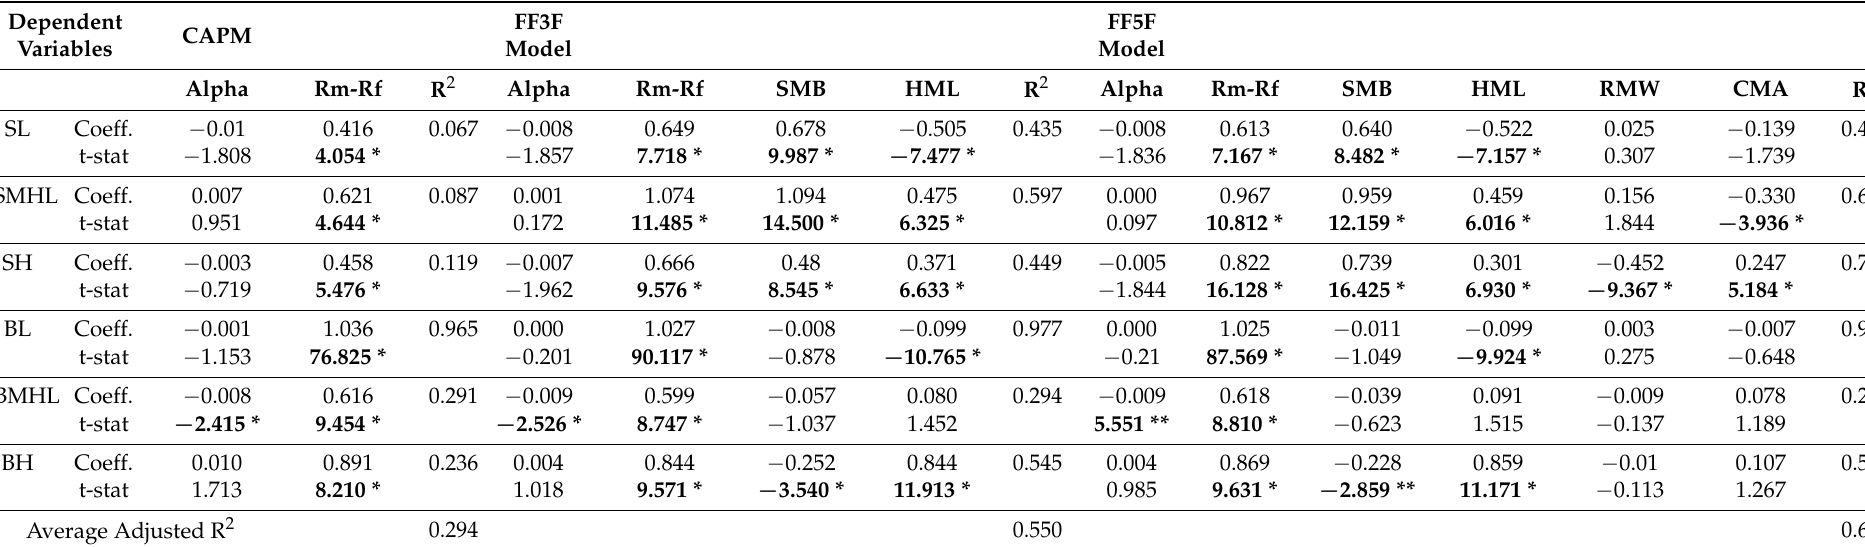
Table 6. Regression results of the CAPM, FF3F model and FF5F model for the 6 value-weighted size–B/M portfolios (July 2002–June